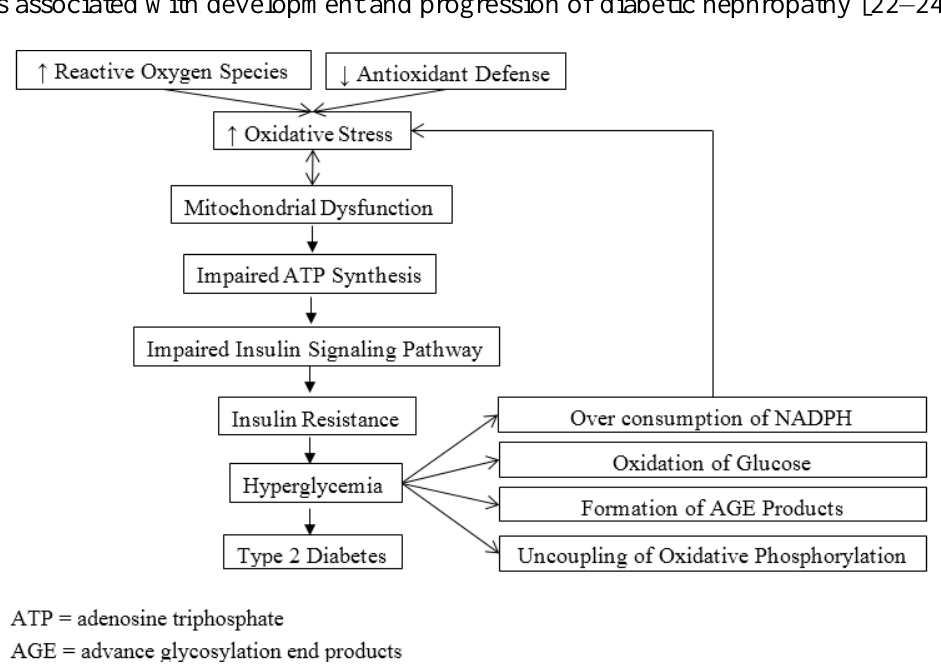
Figure 1. Scheme of the roles of oxidative stress in pathogenesis of type 2